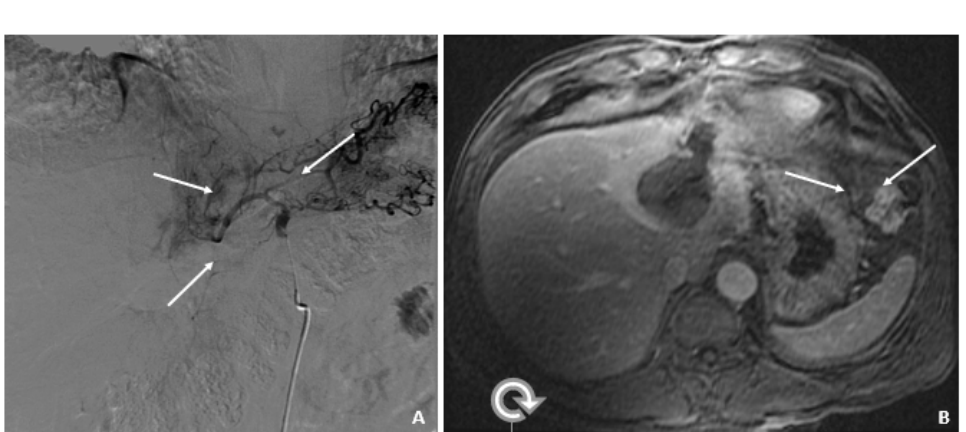
Figure 1. MRI at the time of diagnosis of HCC (December 2009). ( A ) The coronal T2-weighted image shows a mildly heterogeneous mass in the left hepatic lobe (arrow), corresponding to hepatocellular carcinoma. ( B ) The axial T1-weighted fat-suppressed arterial-phase postcontrast image shows faint foci of hyperenhancement within the lesion, characteristic of HCC.